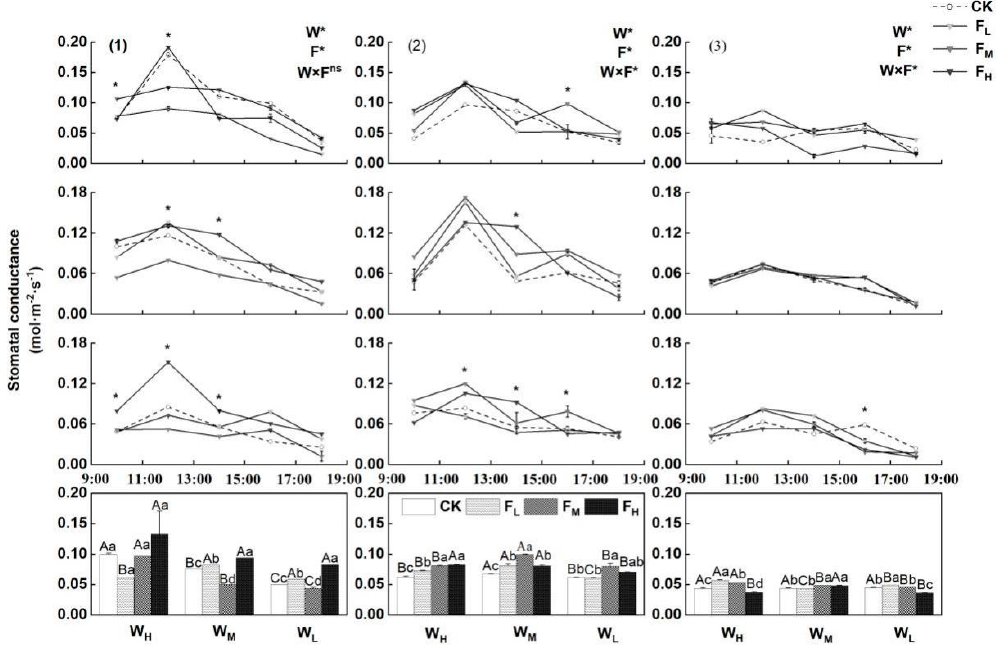
Figure 5. Changes in G s values of test plant species under different water–fertilizer treatments. Numbers ( 1 ) − ( 3 ) in brackets indicate P. crymophila , F. coelestis , and S. purpurea , respectively. W, F, and W × F indicate the results of ANOVAs ( p < 0.05) for the effects of water, fertilizer, and their interactions. Asterisk (*) and ns indicate significant difference and non-significant. The uppercase letters and lowercase letters represent the difference between water and fertilizer treatments.